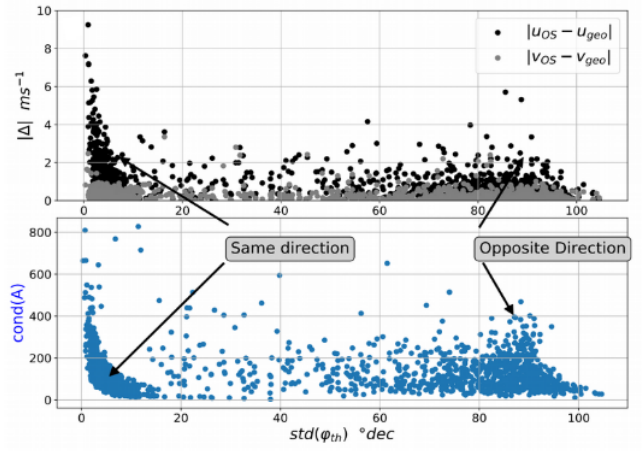
Figure 2. Reliability of the considered linear model observation: the validity of modeling assump- tion depends on the diversity of the observed boat trajectories. We first report a comparison between the absolute error between the AIS-derived and altimetry-derived currents ( top ). We also depict the conditioning of the linear system associated to the considered observation model ( bottom ). The greater the insconsistency between AIS-derived and altimetry-derived currents, the worse the conditioning of the linear observation